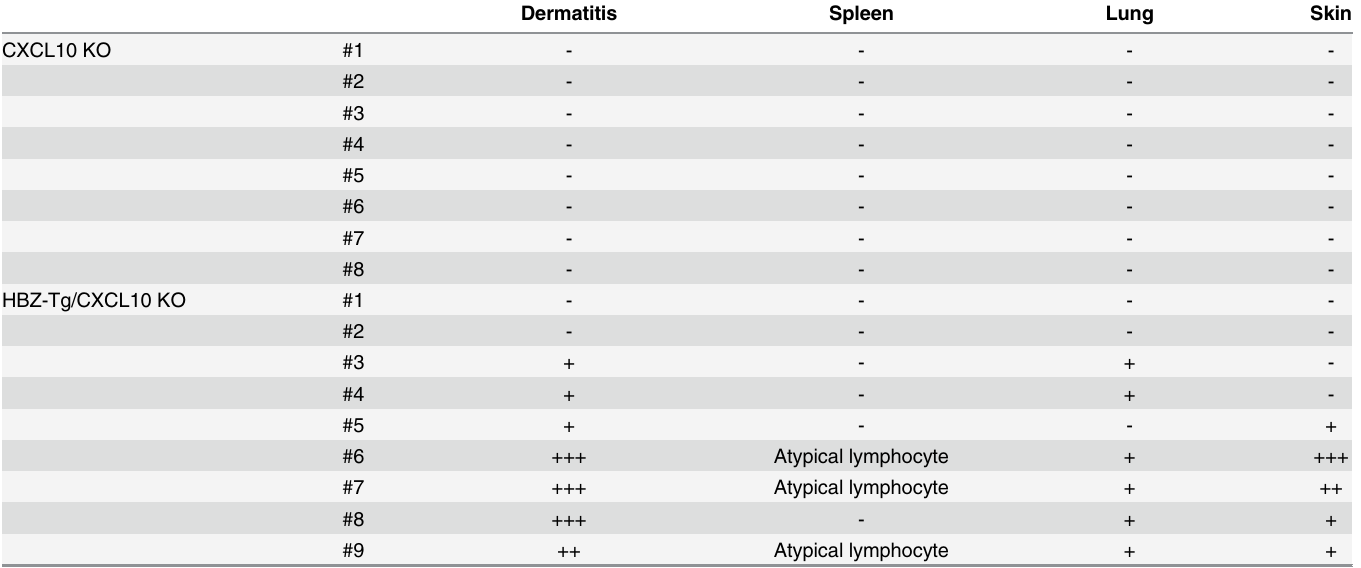
Table 2. Histological findings in CXCL10 KO, and HBZ-Tg/CXCL10 KO mice at 24 weeks of